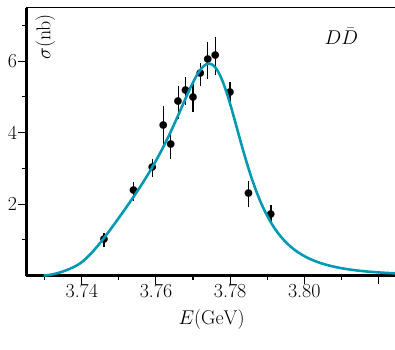
Figure 1. Fit result of the unitarized e ff ective model in [20] to data in